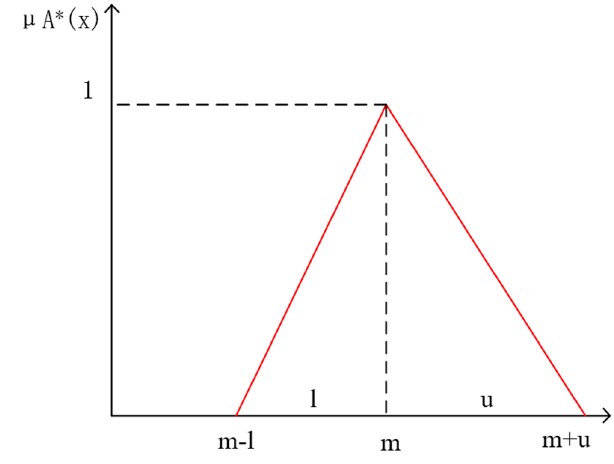
Figure 5. Membership function curve of triangular fuzzy number [18]. Table 3. Scale method[19].